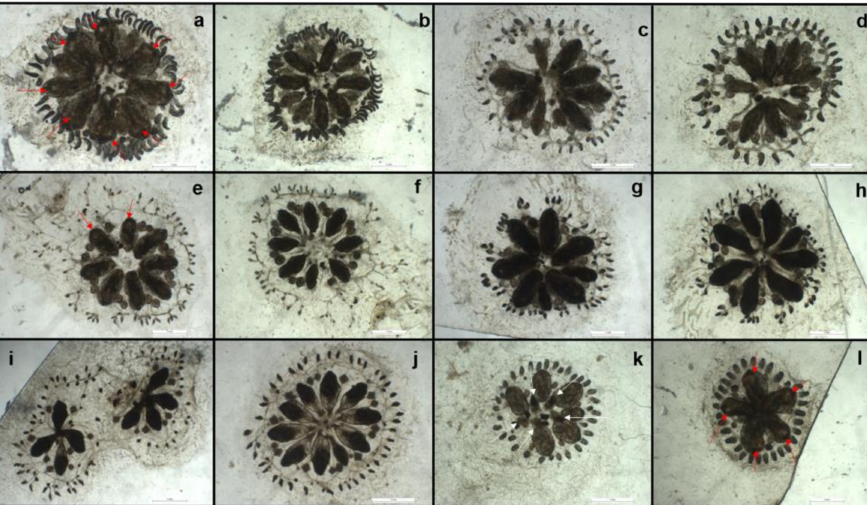
Figure 8. Colonies of B. schlosseri exposed to Cu ions. Colonies exposed to 0.3 mg/L at t 24 ( a ) and at t 48 ( b ); colonies exposed to 0.3 mg/L at t 24 ( c ) and at t 48 ( d ); colonies exposed to 1.0 mg/L at t 24 ( e ) and at t 48 ( f ); colonies exposed to 1.0 mg/L at t 24 ( g ) and at t 48 ( h ); colonies exposed to 5.0 mg/L at t 24 ( i ); colonies exposed to 5.0 mg/L at t 24 ( j ); control colonies (pure medium, without Cu) under take-over at t 48 ( k , l ). White arrows in panel ( k ) indicate reabsorbed adults. Red arrows in ( a , l ) indicate open and actively filtering inhalant siphons. White scale bars: 1